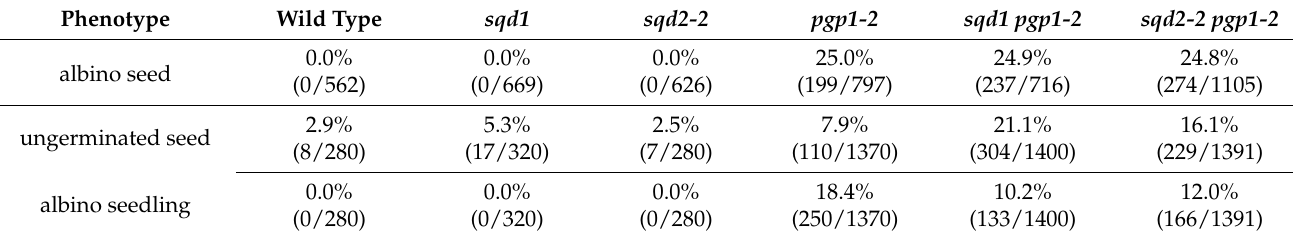
Figure 9. Embryo development in knockout mutants of anionic lipid biosynthesis in plastids. ( a ) Seeds of pgp1-2 , sqd1 pgp1-2 , and sqd2-2 pgp1-2 in the silique at fully developed but before dehydration stages were compared with those of the chlh mutant lacking chlorophyll (Chl) biosynthesis. Plants in the heterozygous state for pgp1-2 or chlh were observed. Scale bar = 0.5 mm. ( b ) Embryos were taken out from albino seeds of each mutant line and observed under a fluorescence stereomicroscope along with wild-type embryos. Images of bright field (upper panel) and Chl autofluorescence (lower panel) were shown. Scale bar = 0.5 mm. ( c ) Embryos in albino seeds of each mutant line at the bent cotyledon or matured stage were compared with those of wild type under a differential interference contrast microscope. Scale bar = 0.5 mm. Table 2. Percentage of albino seeds, ungerminated seeds, and albino seedlings of wild type and anionic lipid